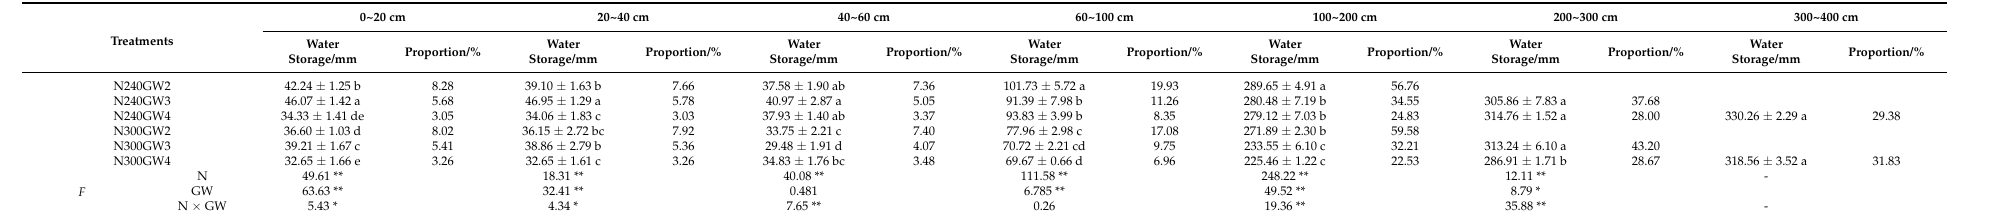
Table 3. Soil water storage in each soil layer in winter